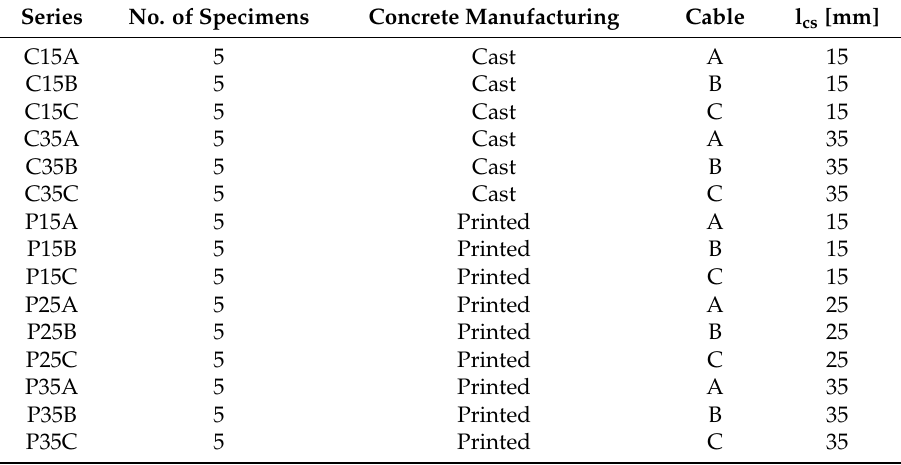
Table 2. Specimen series overview.